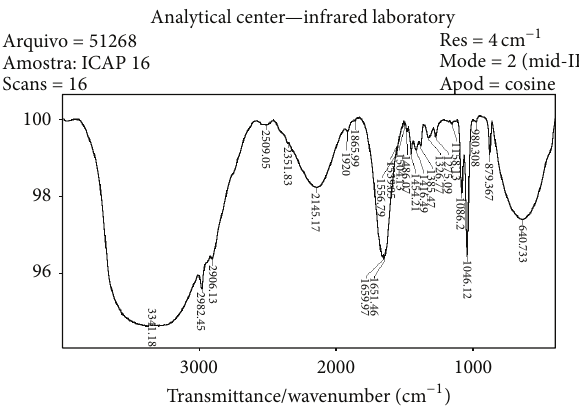
Figure 1: IR spectrum of a sample of Brazilian cachac¸a showing the main bands: at 3341–2906 cm −1 attributed to O–H stretching of alcohols, water, carboxylic acids, and amides; at 2145 cm −1 attributed to the asymmetric vibration of NCO − in cyanate-copper complexes; at 1659–1651 cm −1 attributed to CO stretching vibrations conjugated with double bonds (C=C) adjacent to a carbonyl group; at 1086 and 1046 cm −1 attributed to stretching vibrations of hydrogen-bonded C–OH alcoholic groups.